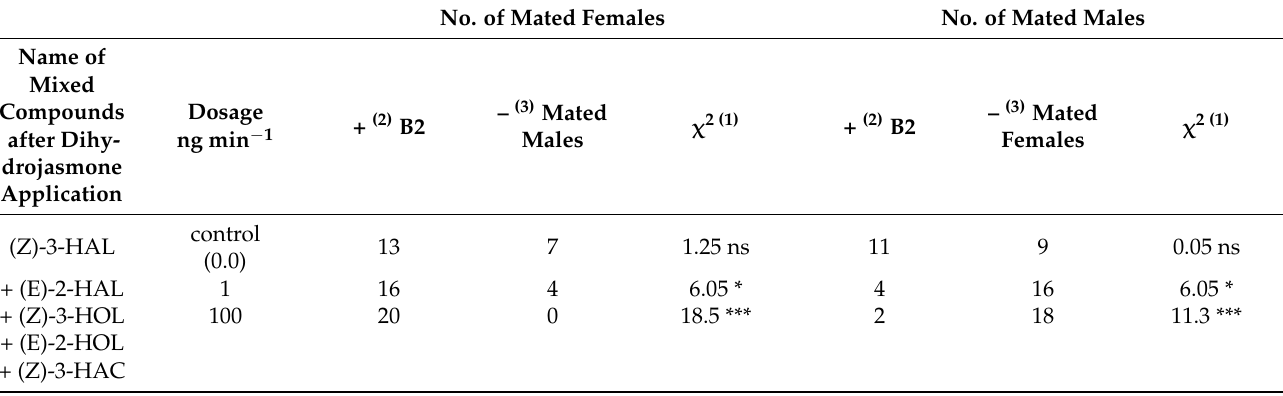
Table 8. The effect of a synthetic blend of three GLVs (blend B2) on mated beetles and on the number of A. miniatum adult females and males choosing to enter a Y-tube arm containing the blend odor or the control Y-tube arm containing purified, humidified air and hexane solvent (no odor). Only concentrations working as attractants (see Tables 1 and 2) were